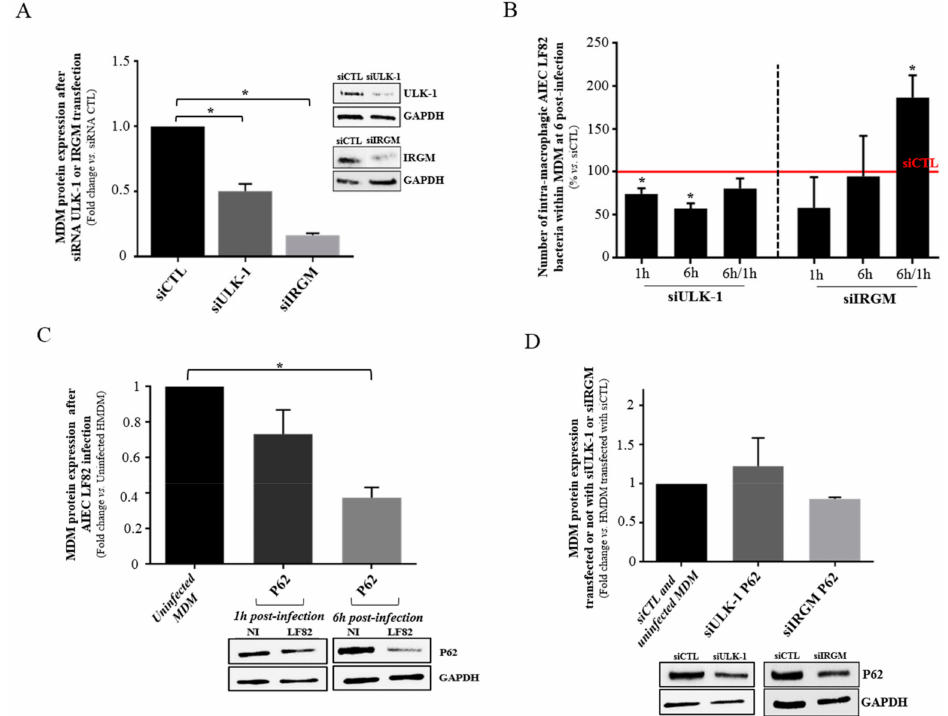
Figure 5. Influence of autophagy-related ULK-1 and IRGM proteins expression on bacterial clearance within MDM from blood donors. ( A ) MDM were transfected with either control siRNA, ULK-1 or IRGM siRNA. ULK-1 and IRGM proteins level was analyzed by western blotting. ( B ) Number of intra-macrophagic AIEC LF82 bacteria at 6 h post-infection within MDM after control, ULK-1 or IRGM siRNA transfection. ( C ) Western blot and quantification of P62 level in MDM infected or not by AIEC LF82 at 1 h and 6 h post-infection. ( D ) Western blot and quantification of P62 level in MDM, after siCTL, siULK-1 or siIRGM transfection after AIEC LF82 infection or not at 6 h post-infection. All MDM were infected by AIEC LF82 at MOI 100. For the western blots, quantification is expressed as amount relative to GAPDH and to uninfected MDM or control siRNA. Data represent results from at least three independent experiments. (mean ± s.e.m., * p <